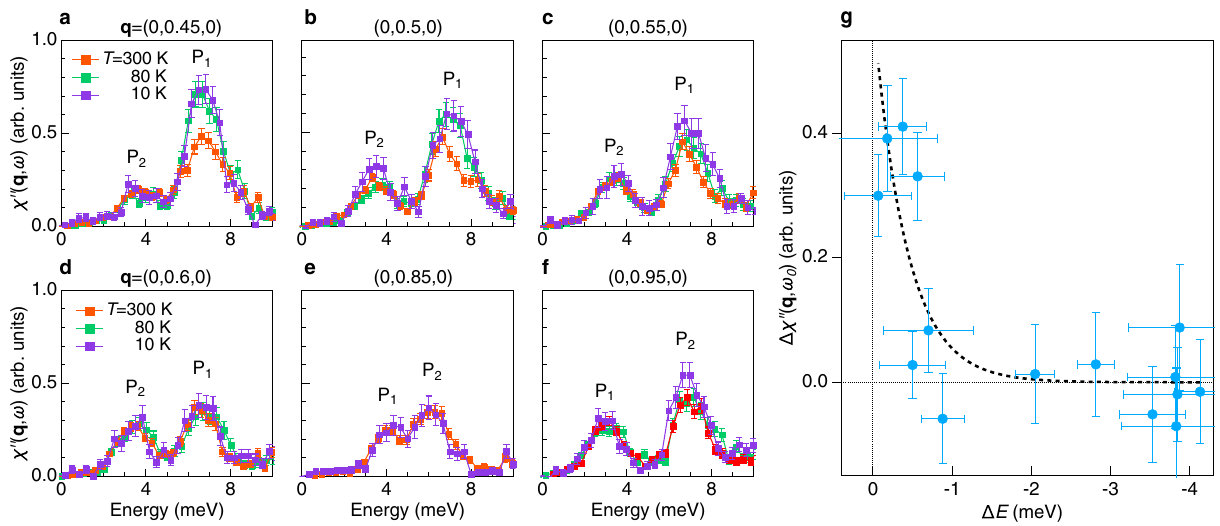
Fig. 3 Itinerant MF-phonon coupling near ω ~ J K . a – f Spectra of the interlaced optical phonons at different reduced momentum transfer q . Here, we de fi ne q = (0, 0, 0) and (0, 1, 0) as Γ 1 and Γ 2 , respectively, where the M point is at q = (0, 0.5, 0). The labels P 1 and P 2 denote the two optical phonon branches. Note the relative peak position of P 1 and P 2 switches at q = (0, 0.75, 0). The temperature dependent χ 00 ð q ; ω Þ shows a spectral weight enhancement at ω (cid:2) J K at low temperature. In b we notice a shoulder on P 2 that may come from the acoustic mode. g The difference in the integrated phonon spectral weight, Δ χ 00ð q ; ω 0 Þ , between 10 and 300 K as a function of Δ E ¼ ω 0 (cid:3) ω max . Here ω 0 is the phonon peak position, ω max = 7 meV is the band top of the interlaced optical phonons. The drastic increase of Δ χ 00ð q ; ω 0 Þ is fi tted to an exponential function (dashed line). The vertical error bars in all panels represent one standard deviation based on Poisson counting statistics. The horizontal error bars in g denote the 2 σ returned from the fi tting algorithm that extract the spectral peak